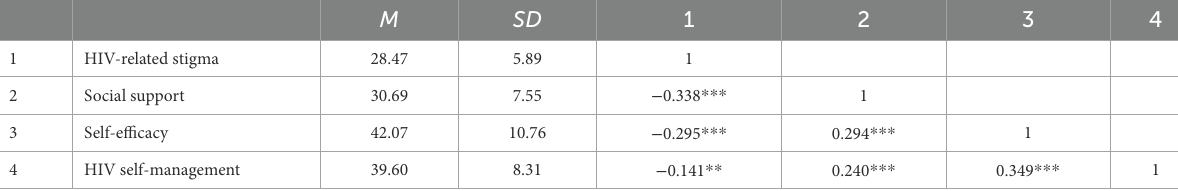
TABLE 2 Means, standard deviations, and correlations for study variables ( N = 459).